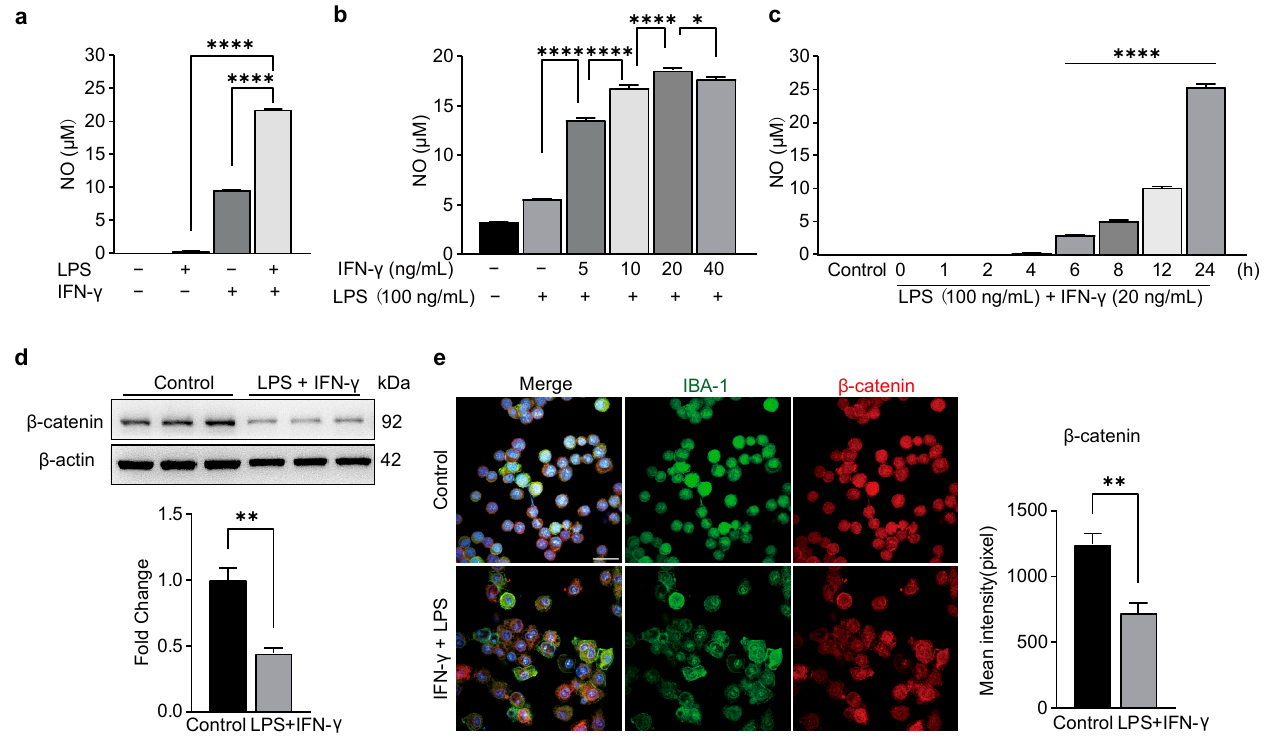
Figure 1. BV-2 cell activation led by LPS and IFN- γ inhibited the expression of β -catenin. A Griess reaction kit detected NO production in the supernatant ( a – c ). ( a ) NO production in the supernatant after incubating BV-2 cells for 24 h with LPS (100 ng/mL), IFN- γ (20 ng/mL), or both. One-way ANOVA, F (3, 8) = 52,697, **** p < 0.0001, n = 3. ( b ) The dose-dependent reaction of IFN- γ combined